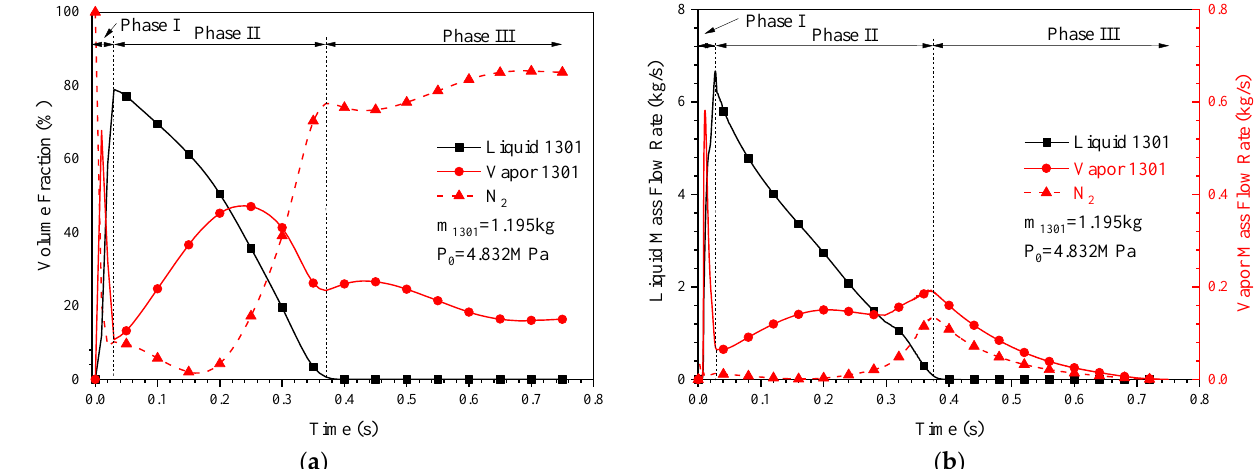
Figure 5. Variation curves of each component at the pipeline outlet: ( a ) volume fractions and ( b ) mass flow rates.